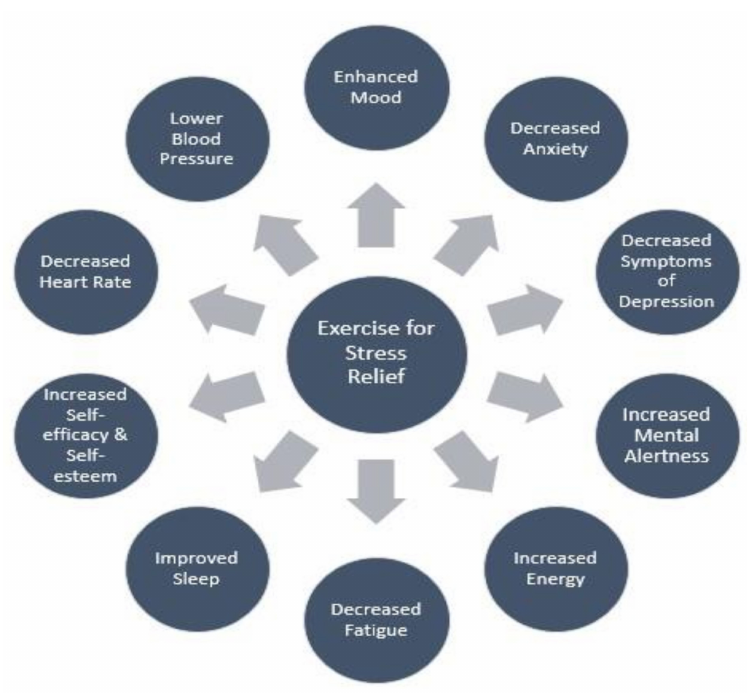
Figure 2. Potential stress reducing effects of regular lifestyle physical activity, structured endurance exercise, or